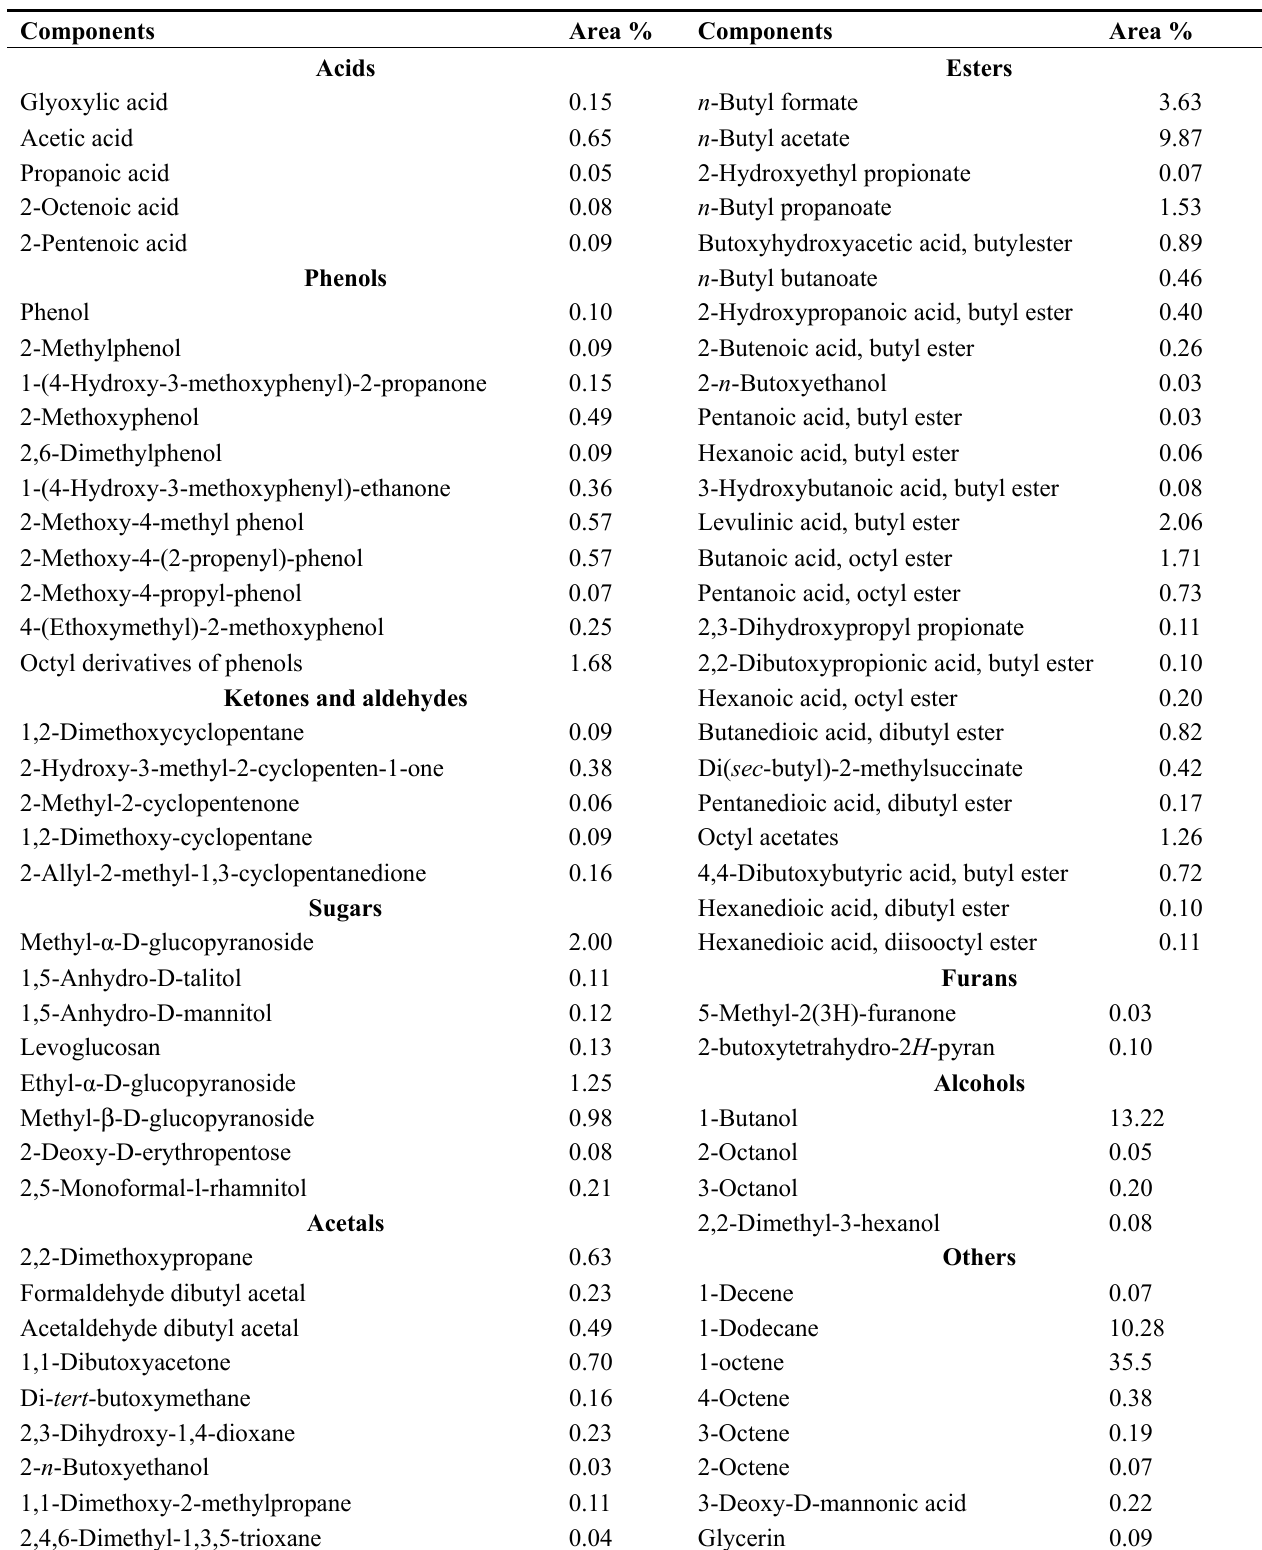
Table A2. Selected organic oxygen-containing components of bio-oil upgraded with 1-octene/1-butanol at 120 °C for 3 h a